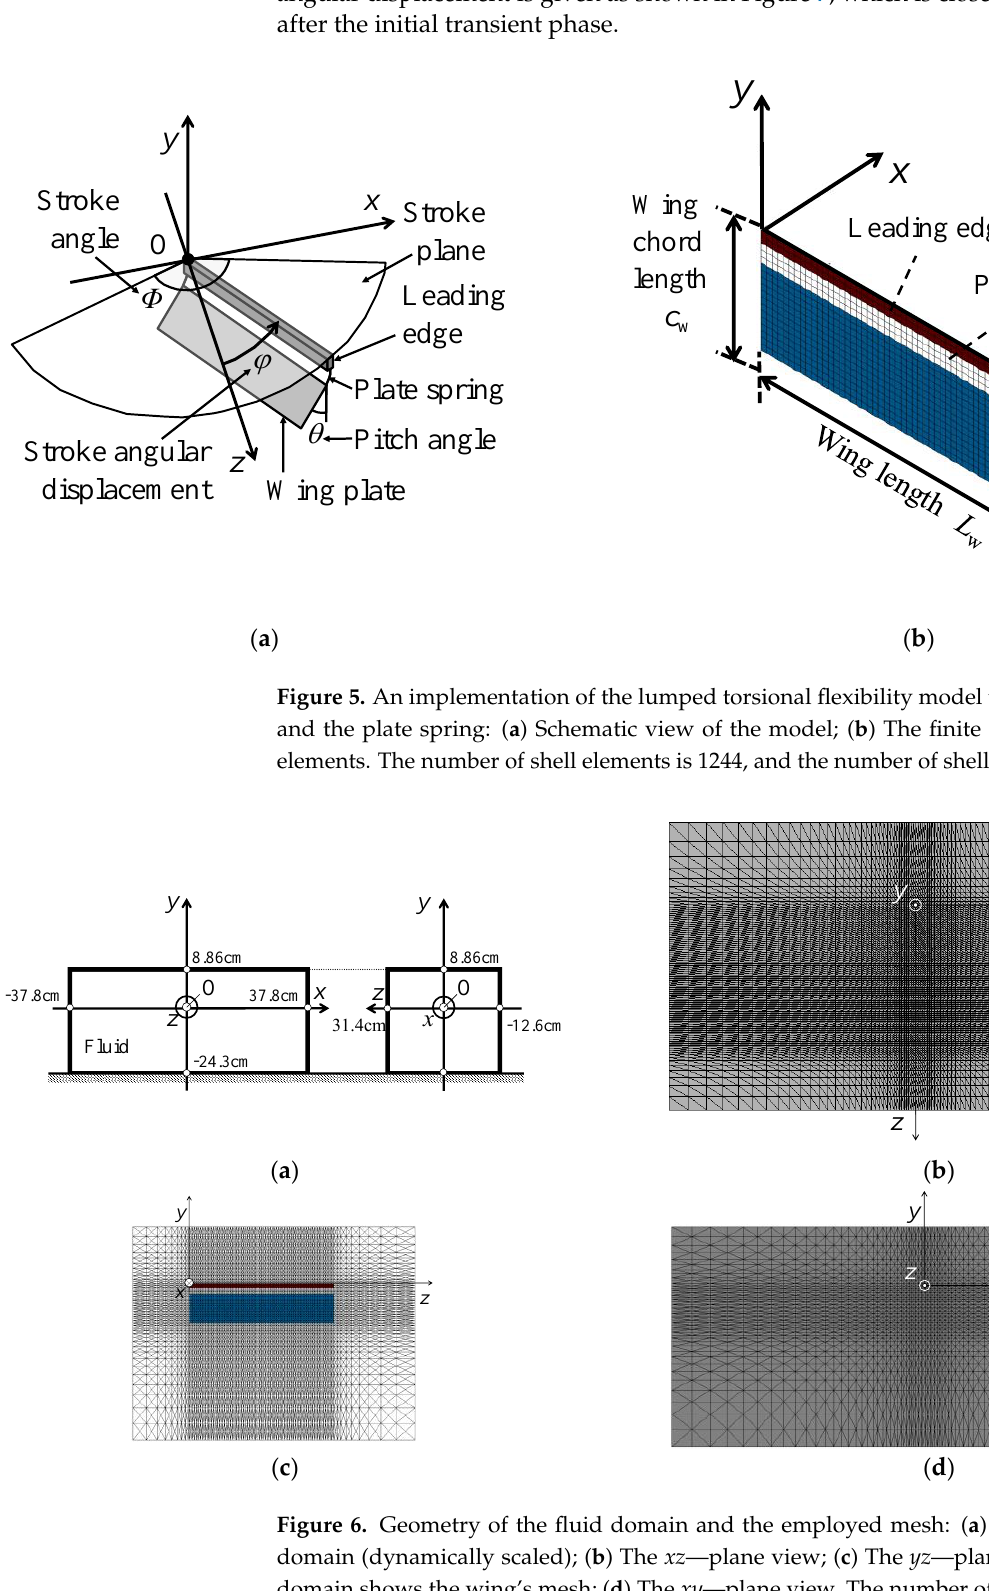
Figure 7. Time histories of the flapping angular displacement. The history during the first one cycle is for the initial transient phase. Table 1. Summary of the model parameters for the insect and dynamically scaled wings. Parameters